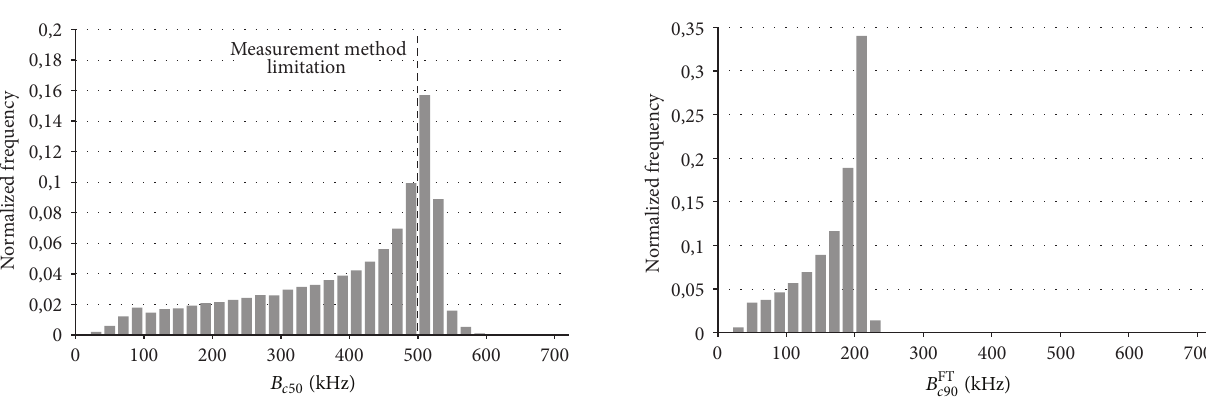
Figure 15: Histogram of coherence bandwidth values estimated from rms delay spread for correlation level 0.5 in hilly terrain.